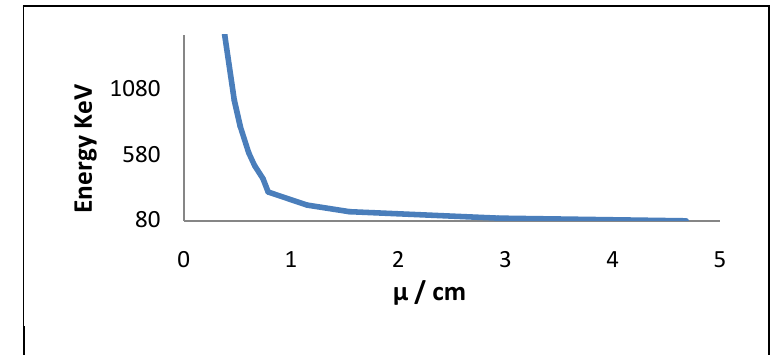
Fig.4 : The relation between energy and linear attenuation